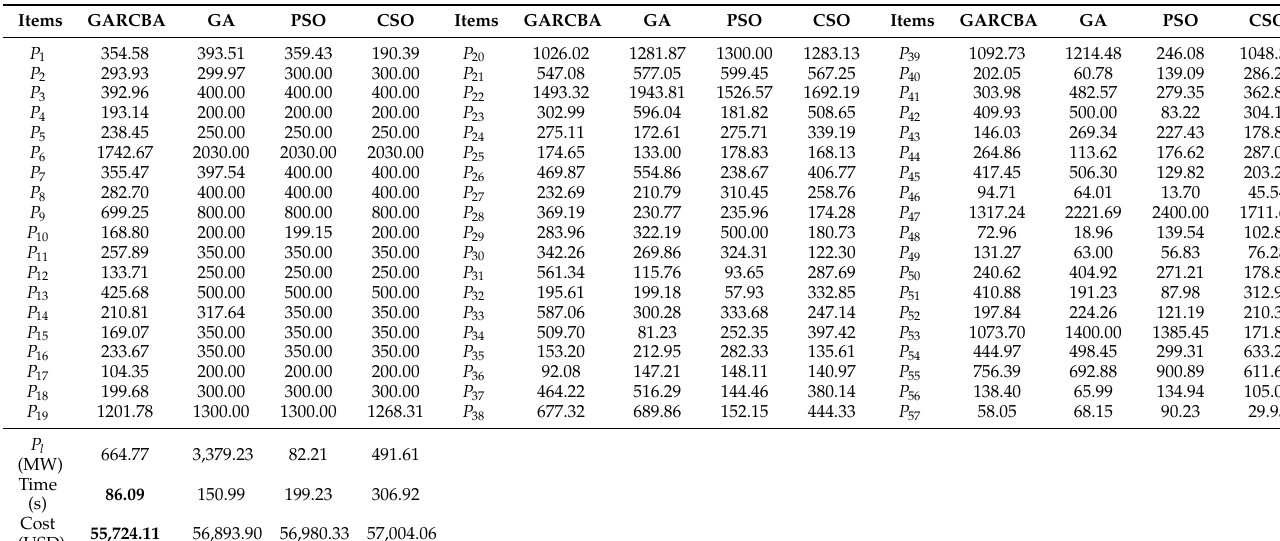
Table 7. Best cost solutions for Case 2 from 25 runs.